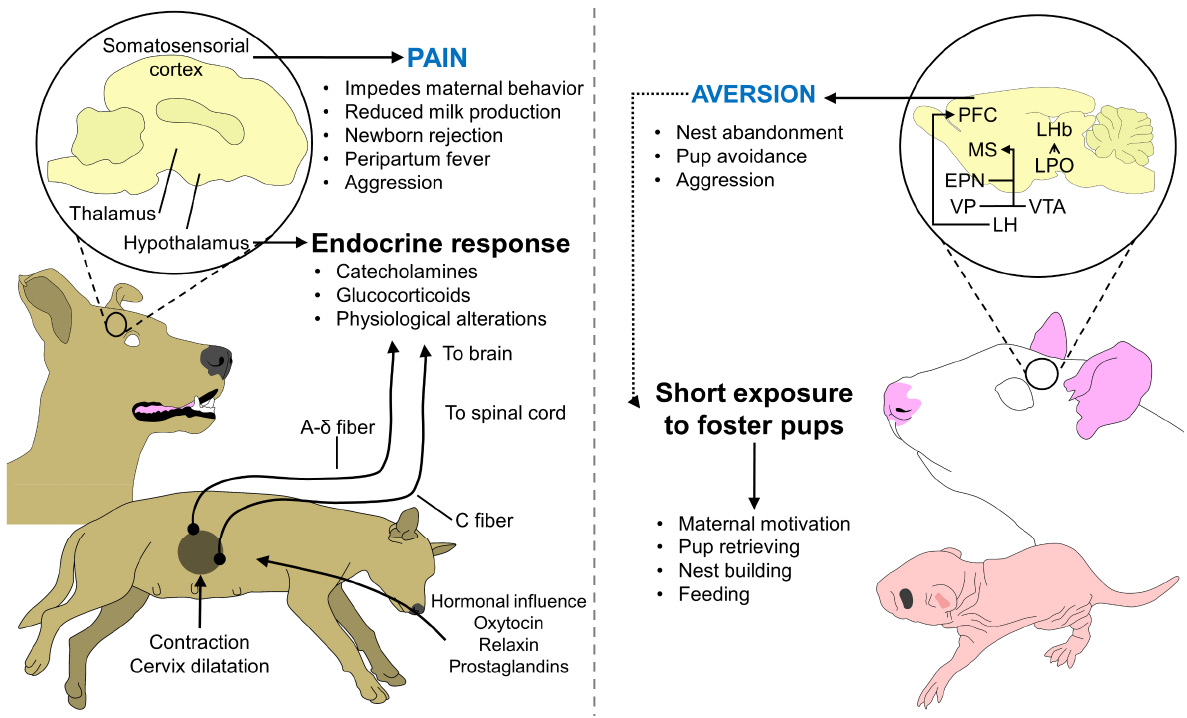
Figure 3. Influence of pain and aversion on maternal behavior in altricial species. Although pain is a physiological trait in the parturition process, if dystocia occurs and the pain is prolonged in the mother, the activation of nociceptors (A ‐ delta and C fibers) activates the sympathetic nervous system, and the consequent release of catecholamines and glucocorticoids. Moreover, the conscious recognition of pain in the somatosensorial cortex alters maternal behavior and reduces milk production, resulting in a negative trait for both the mother and the offspring. On the other hand, the activation of aversion pathways in non ‐ parturient females prevents them from maternal responsiveness. However, in species such as rodents, short periods of pup exposure elicit similar responses in multiparous, parturient, and lactating animals. EPN: entopeduncular nucleus; LH: lateral hypothalamus; LHb: lateral habenula; LPO: lateral preoptic area; MS: medial septal nucleus; PFC: prefrontal cortex; VP: ventral pallidum; VTA: ventral tegmental area.